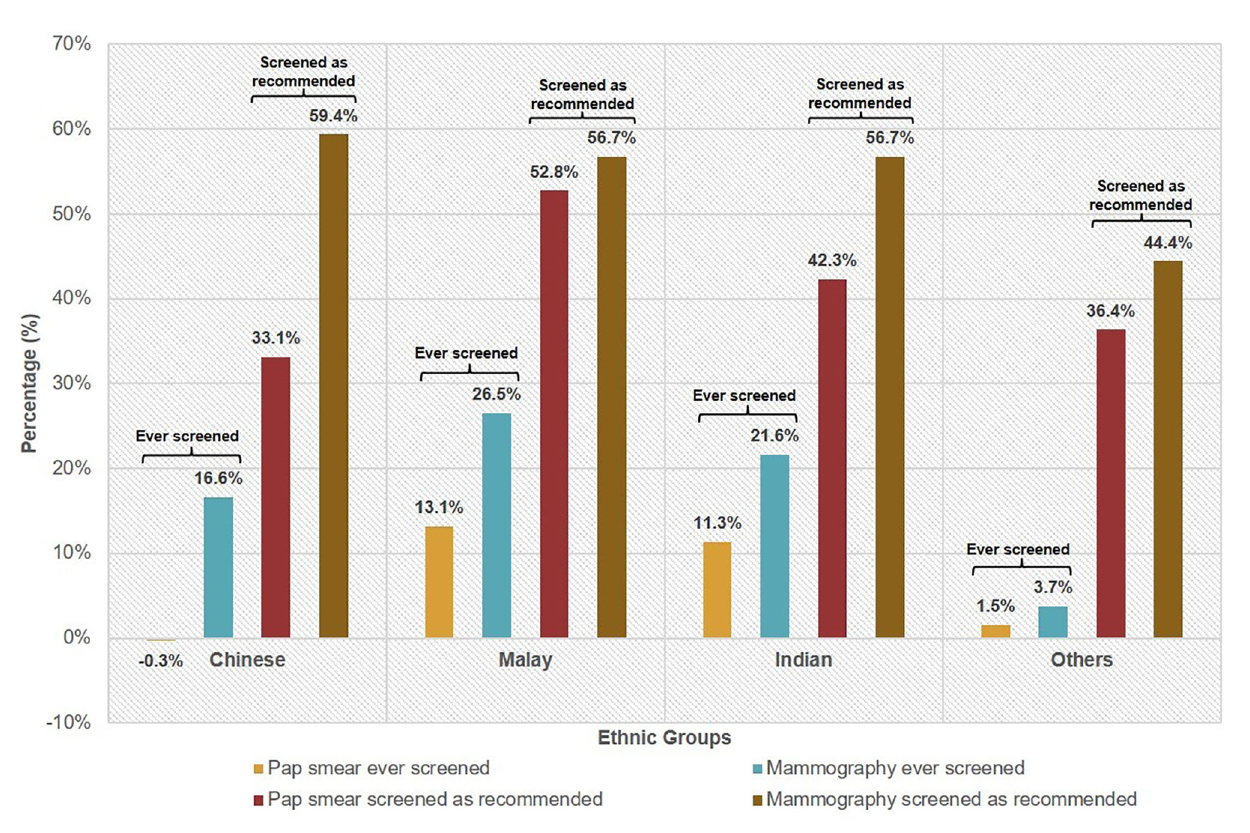
FIGURE 1 | Knowledge – behaviour gap ╤ of female cancer screening* by ethnicity. ╤ Knowledge – behaviour gap is de fi ned as the difference in proportions between those that reported having knowledge of the screening test and those that ever did the screening test or screened as recommended. *Based on recommended screening guidelines for selected cancers as de fi ned by MOH guidelines: cervical cancer — Pap smear for sexually active females aged 25 to 69 years at least once every 3 years; breast cancer — mammography for females aged 50 to 69 years every 2